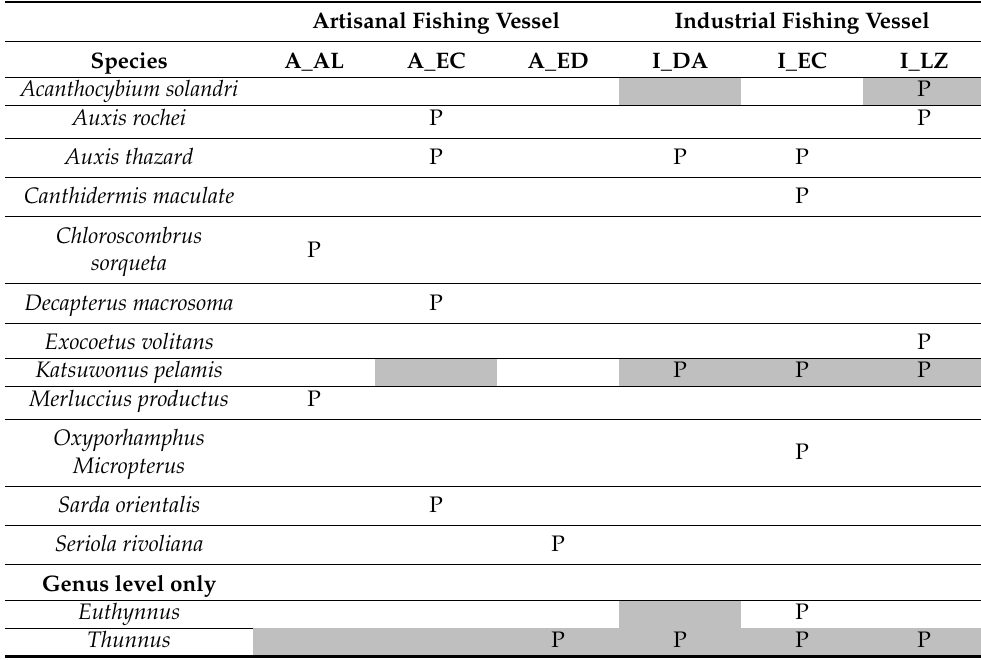
Table 2. Species- or genus-level taxa identified in eDNA samples as present (P) in artisanal and industrial fishing vessels. Grey highlighting signifies taxon was listed by crew/captain as targeted fish in